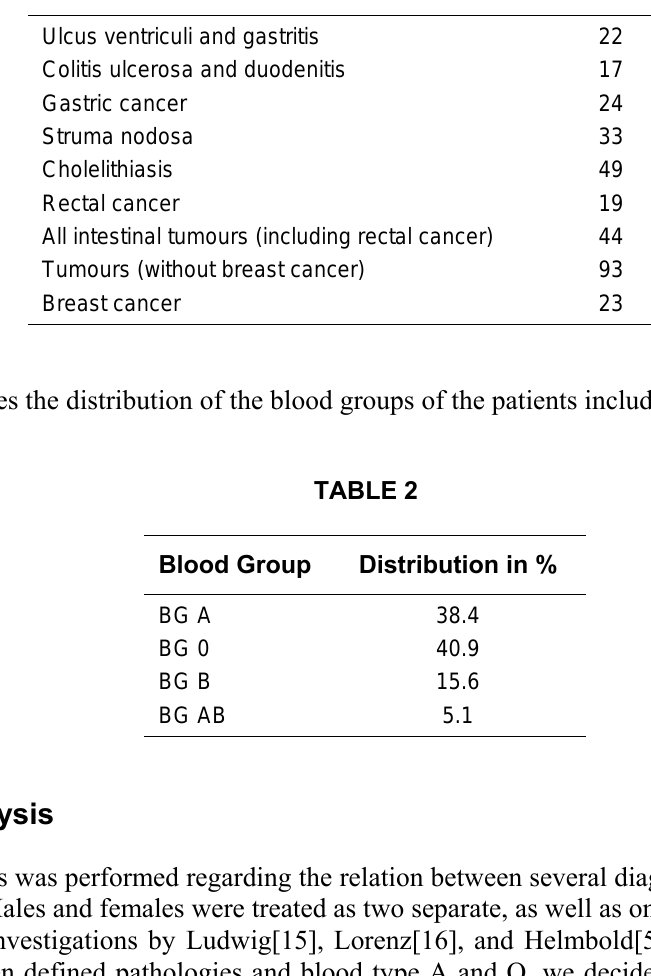
Disease Patients (N) Ulcus ventriculi and gastritis